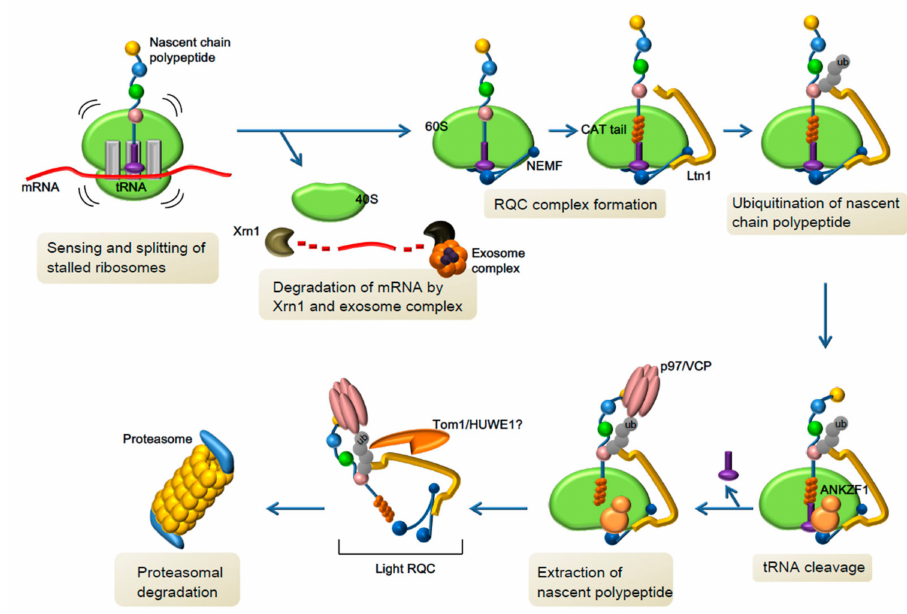
Figure 3. Ribosome-associated quality control. The RQC pathway is initiated after the sensing and splitting of stalled ribosomes by proteins including GTPBP2, HBS1L, Pelota, and ABCE1. Whereas the 40S-associated mRNA is degraded by exonuclease Xrn1 and the exosome complex, RQC mediates the ubiquitination, CATylation, and extraction of the nascent chain polypeptide for its eventual degradation by the proteasome. The RQC complex is mainly consisted of Ltn1 and NEMF, which recognizes aspects of a stalled 60S subunit, including a protruding tRNA and a surface which would otherwise be interacting with the 40S subunit. In this complex with the 60S ribosome, the RING domain of Ltn1 is perfectly situated such that it sits near the ribosome exit tunnel, thus allowing it to ubiquitinate the nascent chain polypeptide. Conversely, NEMF mediates the mRNA- and 40S-independent addition of alanine and threonine residues (CAT tails) to the emerging polypeptide. Finally, NEMF dissociates and is replaced by ANKZF1 to mediate the tRNA cleavage so that the nascent polypeptide chain can be extracted by p97 / VCP and its cofactors. The loss of RQC activity due to genetic removal of its principal components have been shown to result in toxicity in yeast and an ENU-induced Ltn1 mutant was found to cause neurodegeneration in mice. Much remains to be examined to determine how disruptions in the RQC pathway may a ff ect brain functions and whether it has a role in the pathogenic process of various neurological